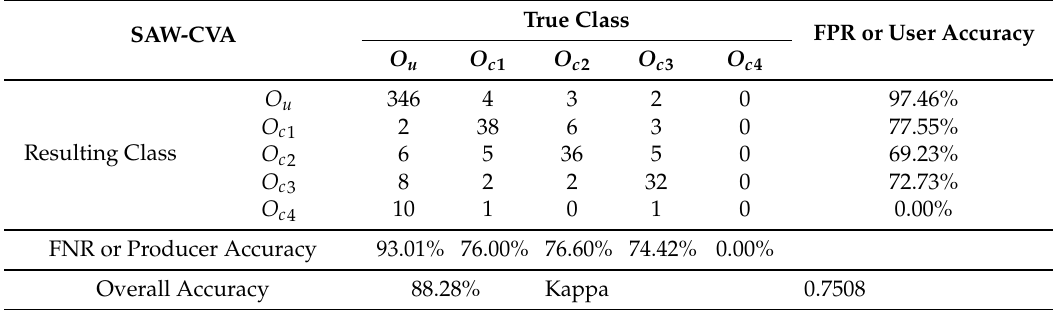
FPR or User Accuracy